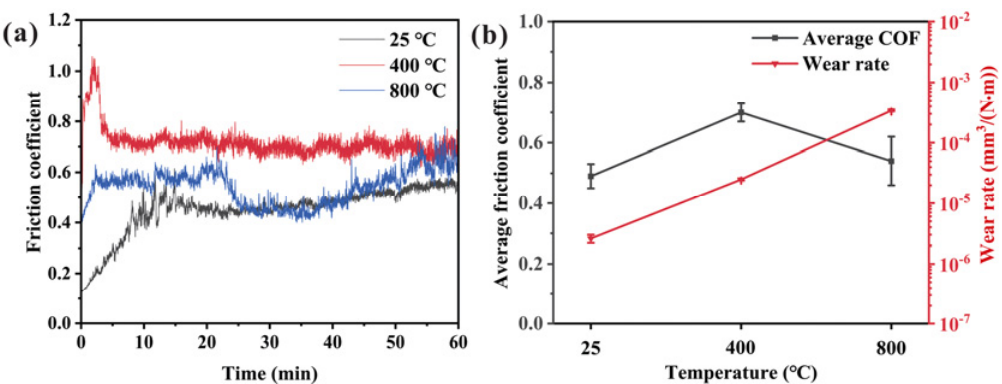
Fig. 9 (a) Typical COF curves of high-entropy (TiVNbMoW)C 4.375 at RT, 400 ℃ , and 800 ℃ ; (b) average COFs and wear rates at RT, 400 ℃ , and 800 ℃ .